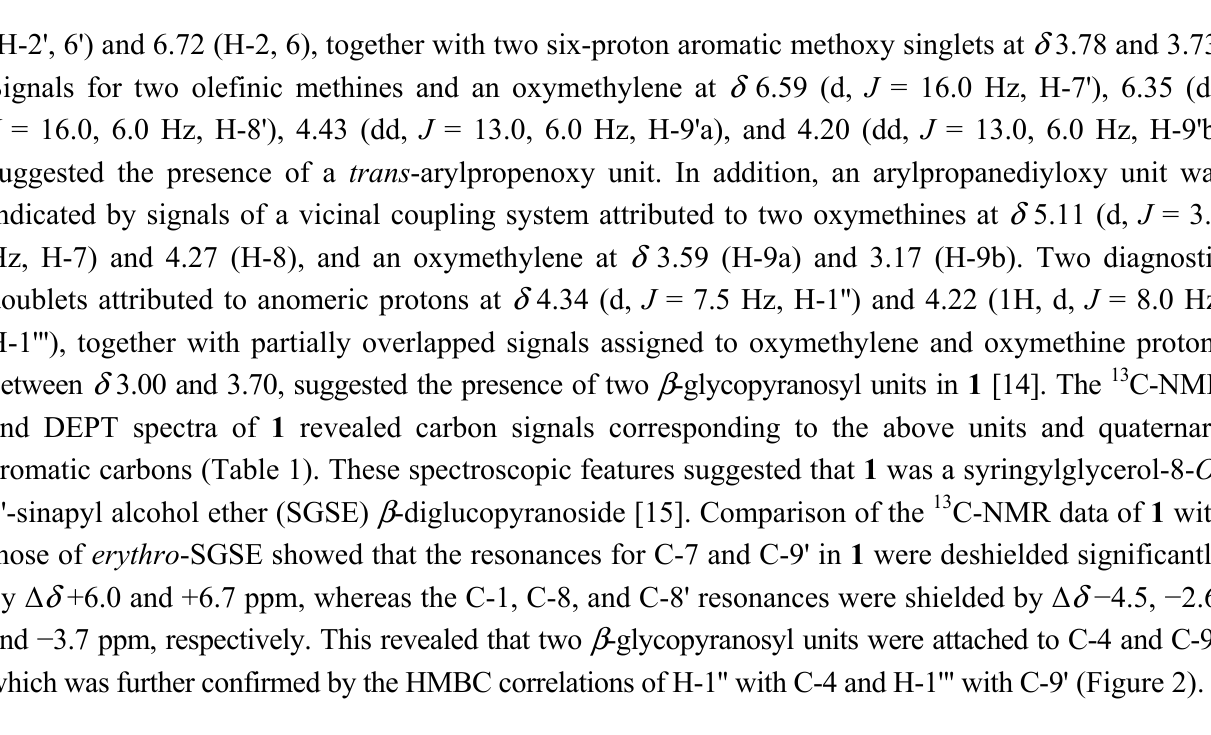
Table 1. 1 H- (500 MHz) and 13 C-NMR (125 MHz) data of 1 (in DMSO- d